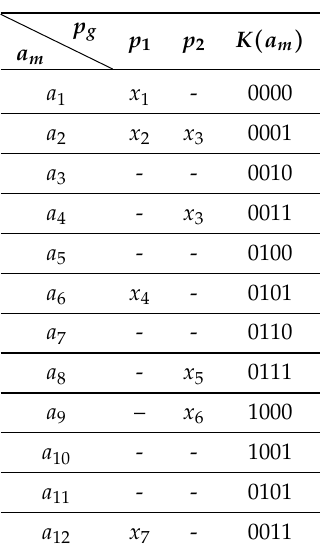
Table 2. Table of replacement X → P .